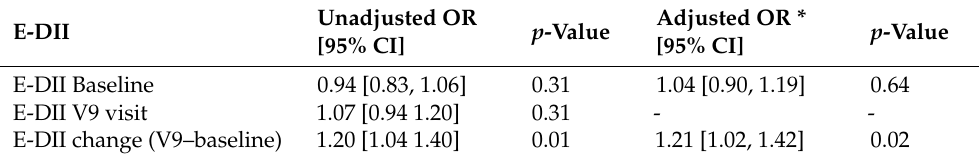
Table 4. Unadjusted and multiple logistic regression of cancer development ( n = 1977).